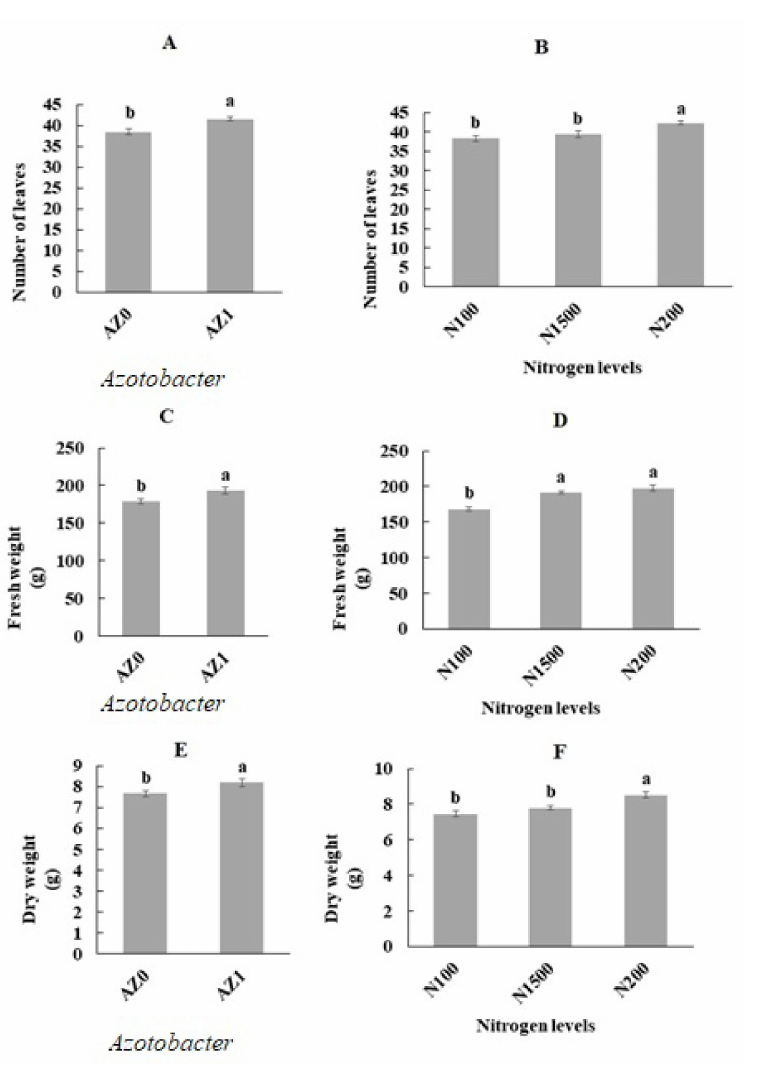
Figure 1. Leaf number, fresh and dry weight of aerial parts in hydroponically grown lettuce influenced by Azotobacter ( A , C , E ) and under different nitrogen levels ( B , D , F ). The letters indicate the mean comparison using LSD test ( p < 0.05) which was implemented for examining the differences among the treatments.